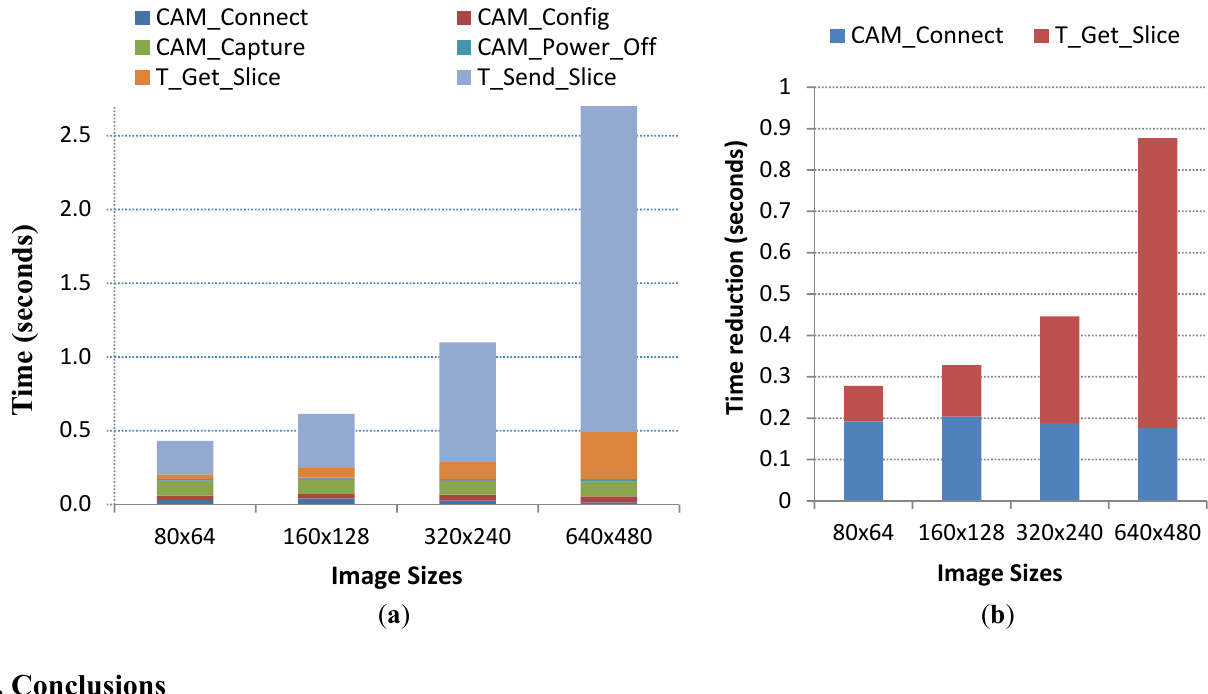
Figure 10. ( a ) Running mode timing profile with the new SPI camera, and ( b ) the absolute time reductions found at CAM_Connect and T_Get_Slice operations for each image